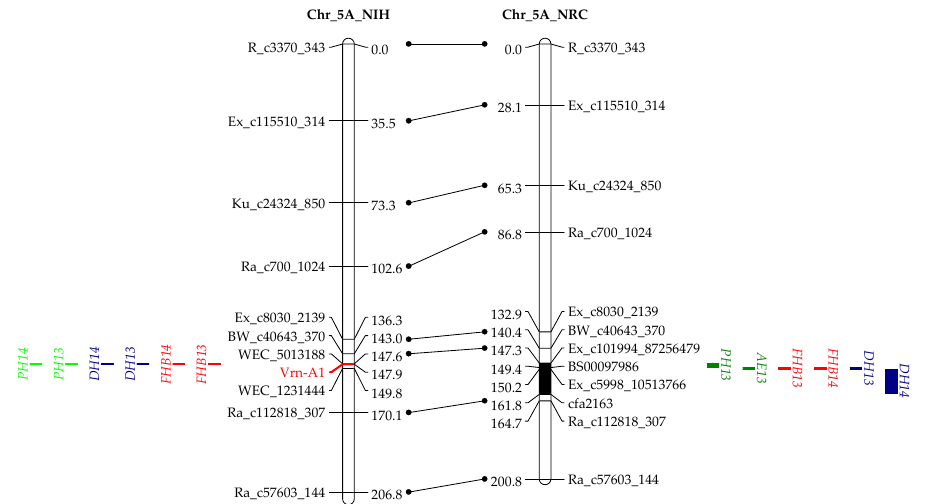
Figure 2. QTL for FHB resistance, anther extrusion (AE), plant height (PH), and days to heading (DH) on chromosomes 3B, 4B, 4D, 5A, and 5B in the “NASMA” × “IAS20*5 / H567.71” (NIH) and “NASMA” × “RPB709.71 / COC” (NRC) populations using the multiple QTL mapping (MQM) method. Genetic distances are shown in centimorgans to the inner or left side of the linkage groups, whereas QTL ranges are denoted to the outer or right side of the linkage groups. Only framework markers are presented except for the QTL regions.